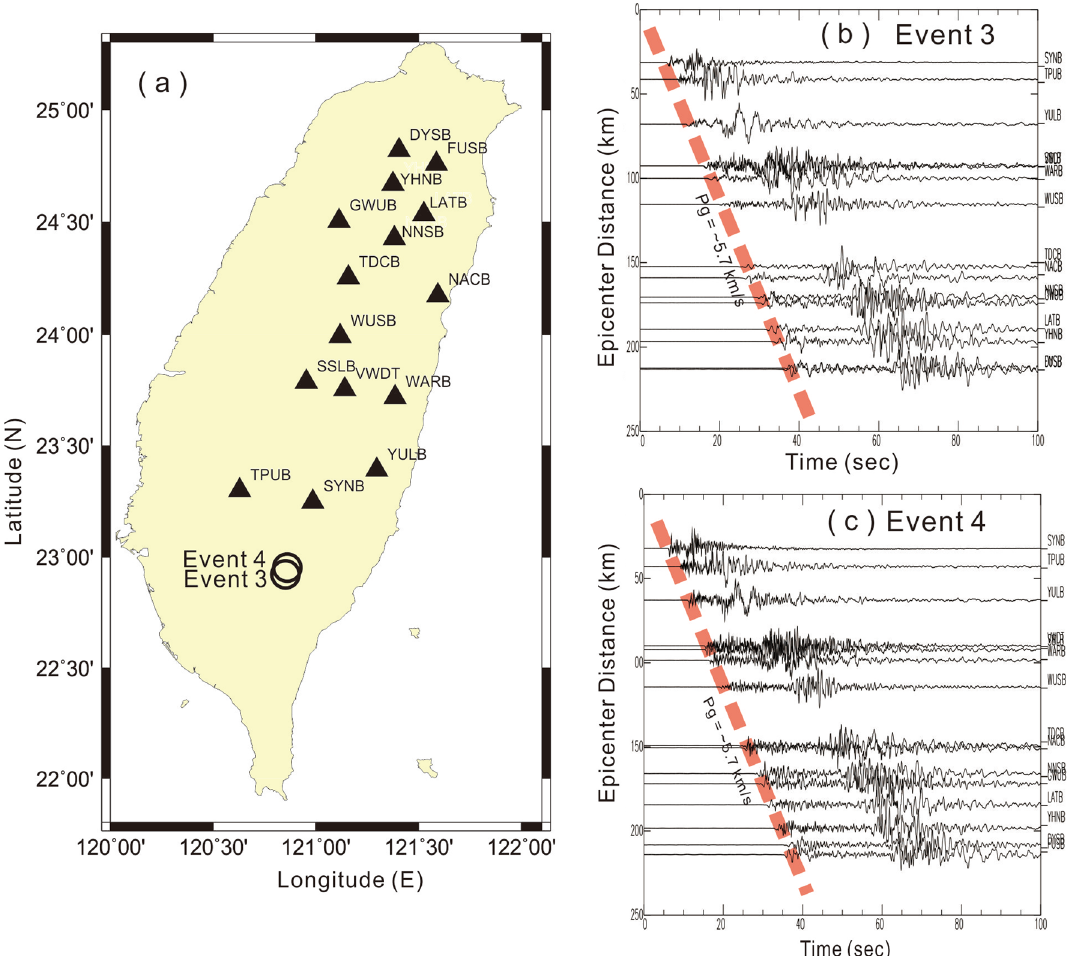
Fig. 5 a Locations of Events 3, 4 and the BATS seismic stations in mountainous area. b , c The observed seismograms plotted with